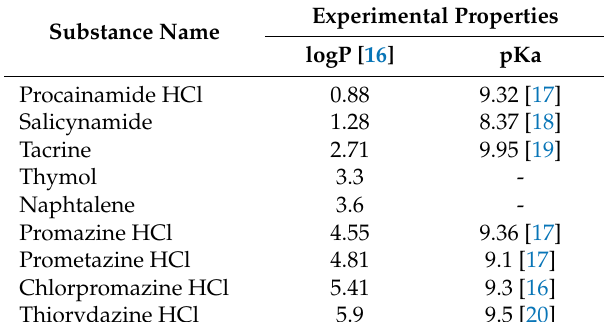
Table 4. Compounds used to perform calibration curve.